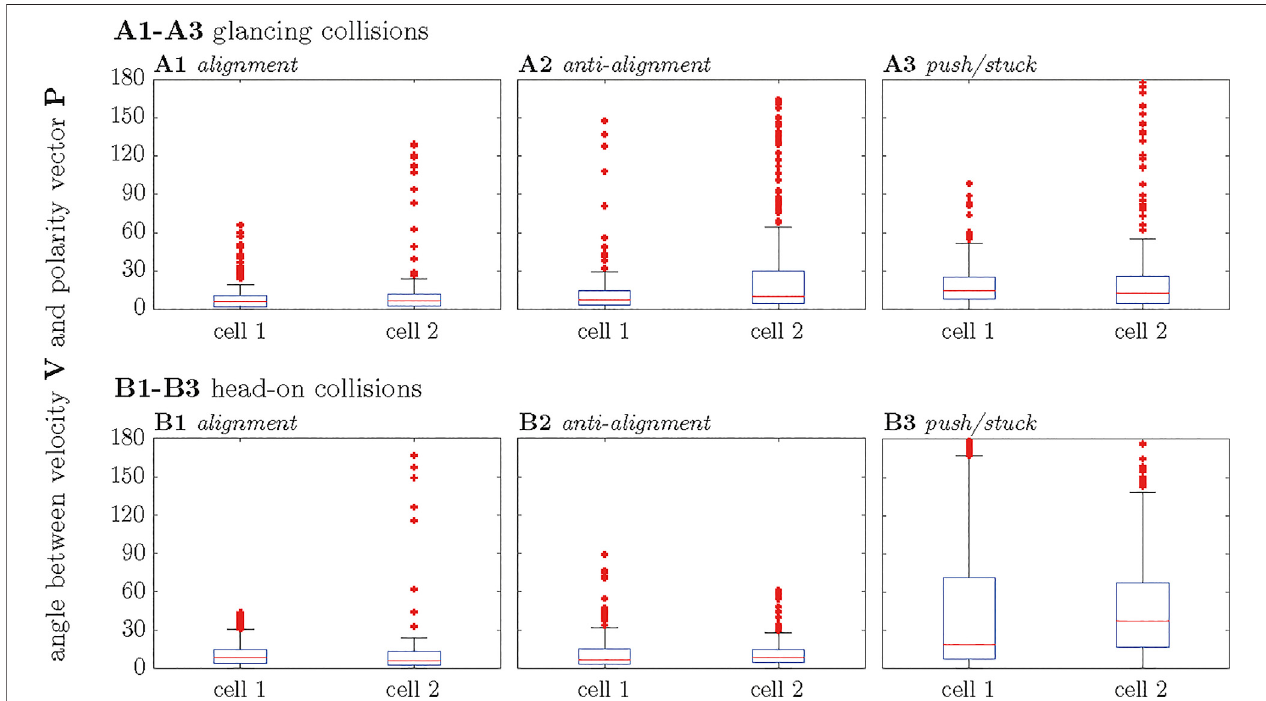
FIGURE 7 | Boxplot representations of the measured angles θ during the interaction of two cells. The panels correspond to alignment, anti-alignment and stuck/ push cases for the glancing collisions (A1 – A3) and heads-on collisions (B1 – B3) , respectively.